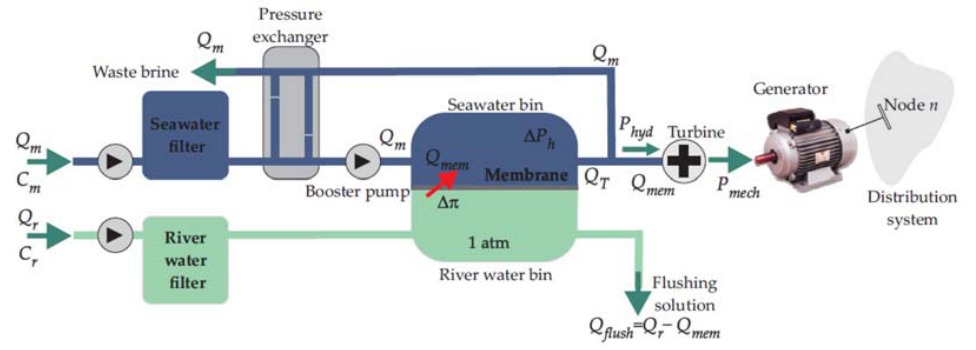
Figure 3. Schematic representation of the PRO power unit.